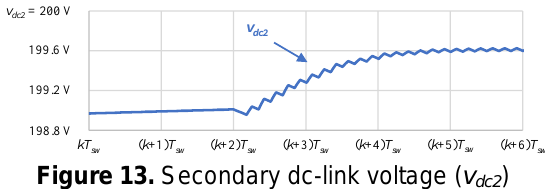
Figure 13. Secondary dc-link voltage ( v dc2 ) regulation considering a DPS